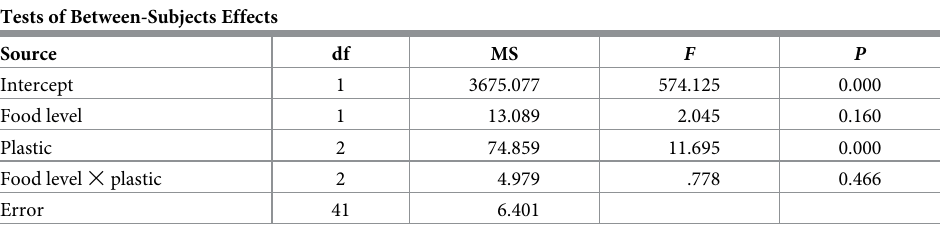
Table 1. Analysis of variance between experimental groups of mussels subjected to different food levels and microplastic. P values < 0.05 were considered